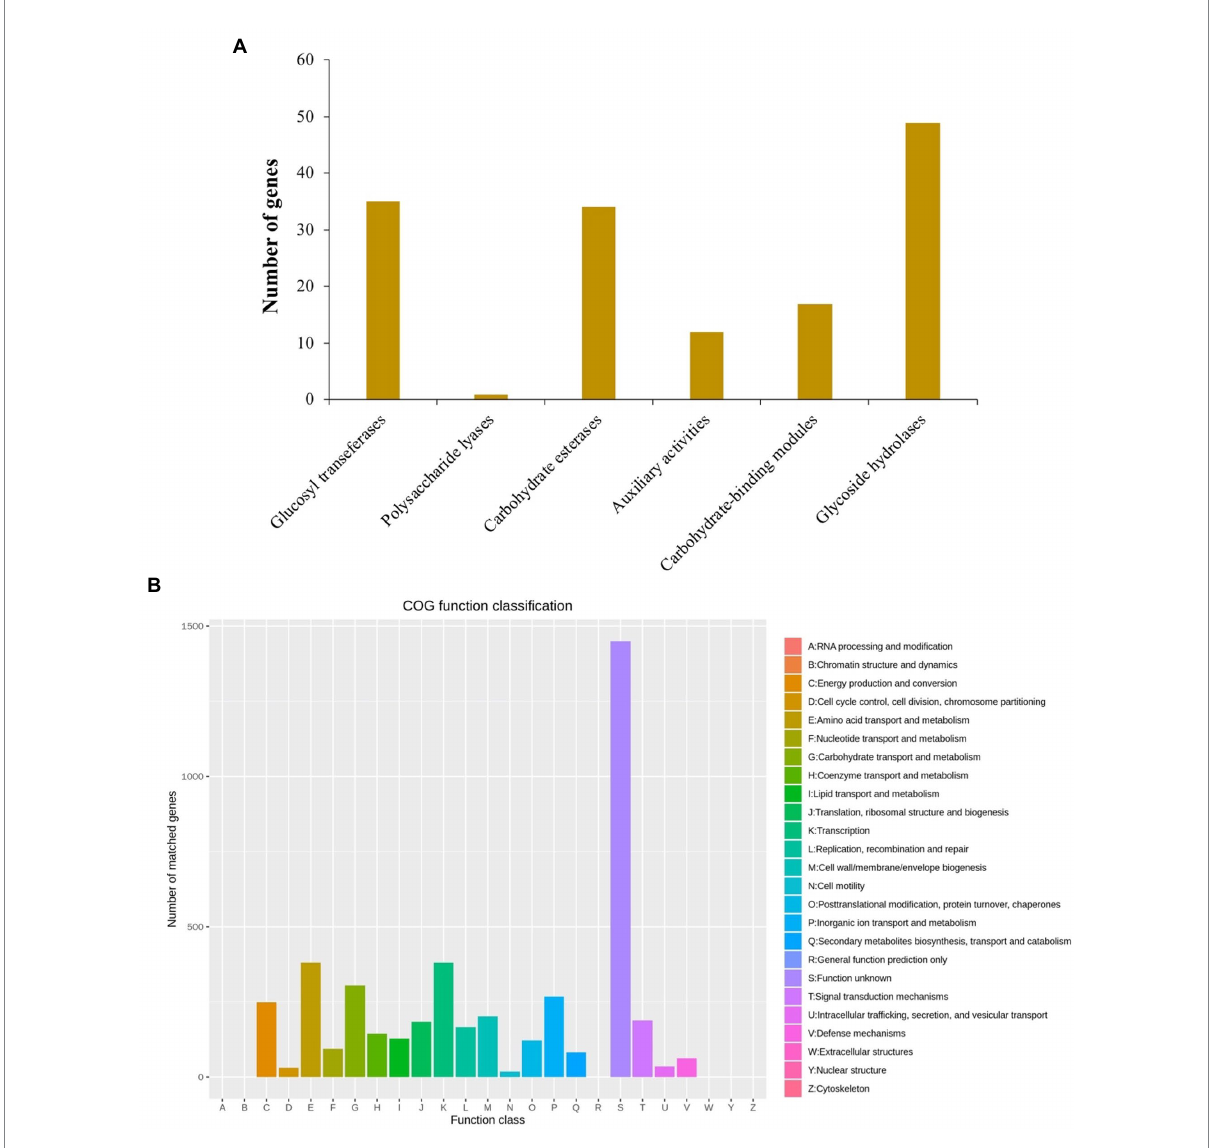
FIGURE 2 (A) Annotation of carbohydrate active enzymes (CAZymes) genes on B. aryabhattai LAD genome. The hmmscan program was used for estimation of the CAZy genes (alignment length > 80 amino acids, E -value <1e-5; alignment length < 80 amino acids, E -value <1e-3). (B) eggNOG annotation. The protein-coding gene sequences were compared to COG database using DIAMOND blastp (cutoff at